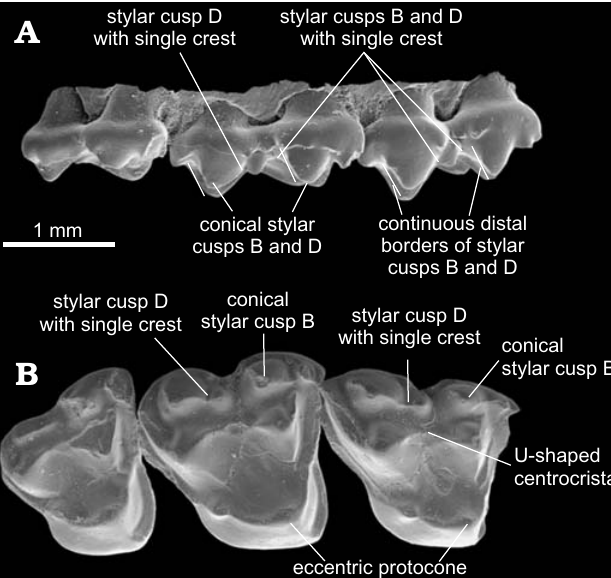
Fig. 4. Upper molars of Glasbius intricatus Clemens, 1966 (UM VP1593) from UCMP V5711, Lance Formation, late Maastrichtian (Lancian NALMA), Wyoming, USA; RP3–M3 in labial ( A ) and occlusal ( B ) views showing this taxon characters. Adapted from Davis (2007: fig.